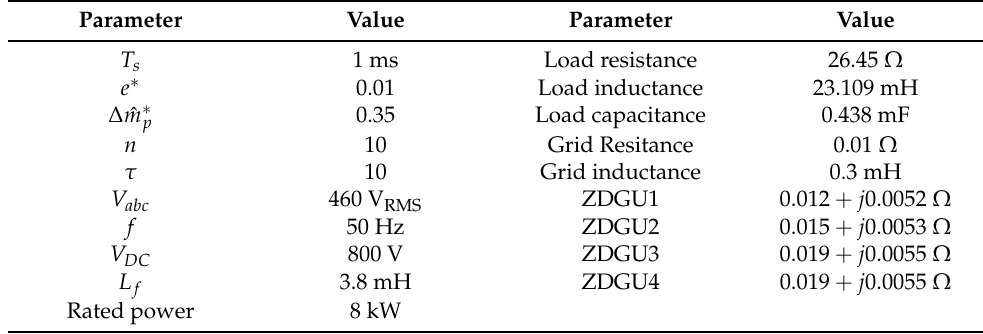
Table 2. Simulation and system parameters.